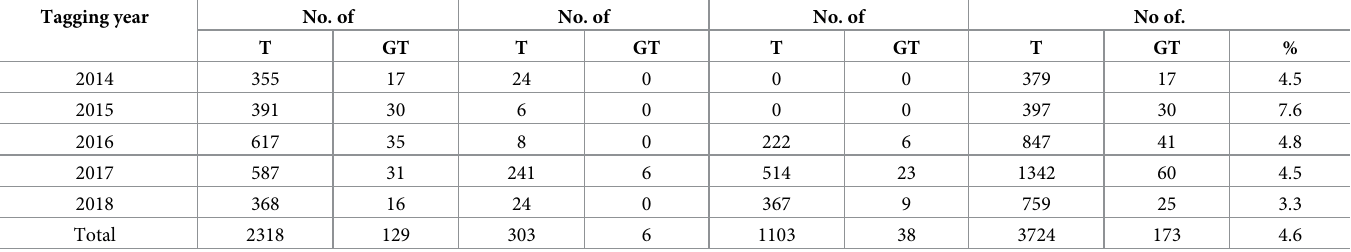
Table 1. Number of implanted tags in 2014 to 2018 (No. of T) and number of ghost tags (GT) identified on the spawning ground from each tagging season. Adult and juvenile asps are presented separately due to different mechanisms of ghost tag production (absence of spawning behaviour). Tagging year No. of